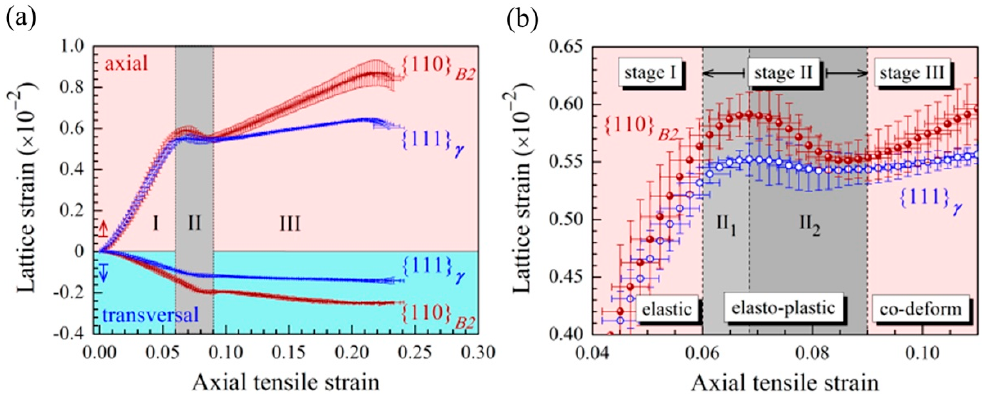
Figure 3. In situ x-ray diffraction measurements for the HSSS with HPS during tensile deformation. ( a ) Lattice strains in both hard B2 phase and soft austenitic matrix vs. applied tensile strain; ( b ) Close-up view for the transient region. Adapted from [28].